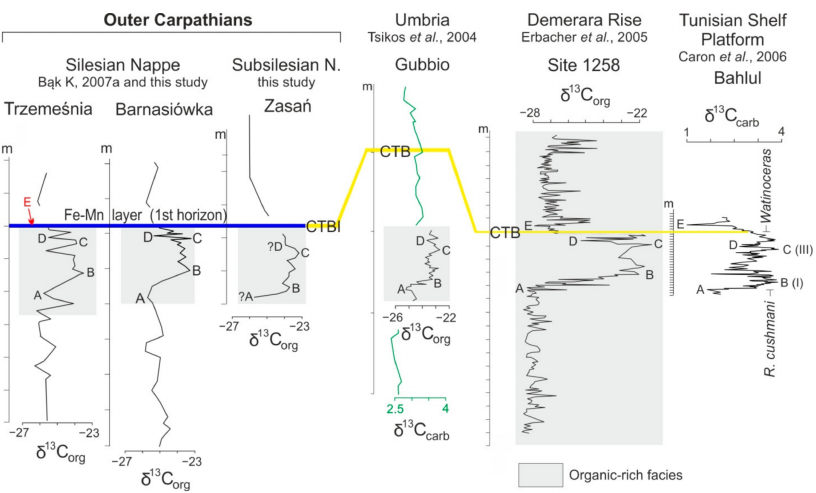
Figure 4. Correlation of Late Cenomanian–Early Turonian δ 13 C org events between Outer Carpathian basins, Umbria–Marche Basin, Central Atlantic, and southern peri-Tehyan shelf. The curves representing Outer Carpathian sections are compared using chemostratigraphic markers with age-calibrated sections from other regions. Note that “B” and “C” markers (positive peaks) correspond to “I” and “III” chemostratigraphic indices sensu [44]. Marker “E” (negative shift) lying close to the Cenomanian–Turonian boundary (CTB) in Tethyan, peri-Tethyan and Atlantic sections is not present in studied succession. The first horizon of the Fe–Mn layer (blue bundle) which overlies Bonarelli-equivalent Level is a regional chronostratigraphic marker displaying onset of oxic conditions in Carpathian domain of Western Tethys. This layer representing an interval of stratigraphic condensation is correlated with the CTB recognized in Gubbio, Site 1258 and Bahlul